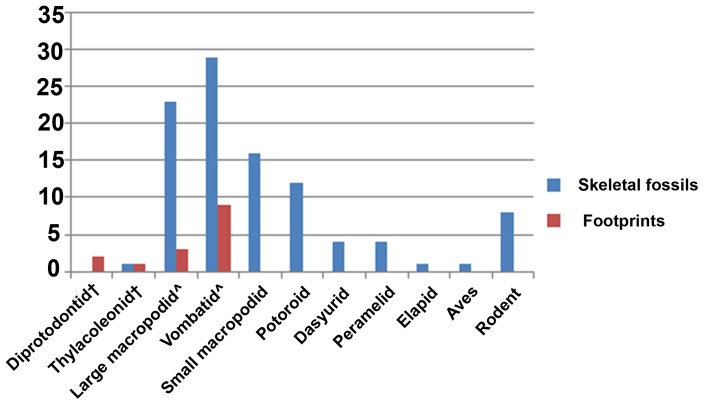
Relative abundance of taxa represented by trace and skeletal fossils.Graph displaying the number of individuals represented by trackways and body (skeletal) fossils at the VVP site. Taxa are arranged by approximate body mass, largest to smallest. † indicates extinct taxa, ∧ the taxa responsible for the macropodid and vombatid tracks at the site may be extinct.